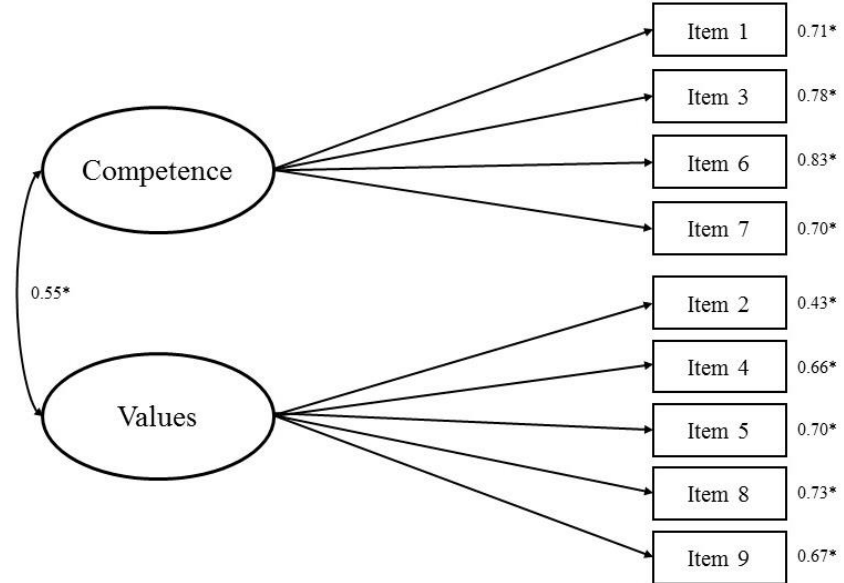
Figure 2. Confirmatory factor analysis results showing standardized estimates with errors for the Korean version of Health Care System Distrust Scale based on the modified two-factor model proposed by Yang et al. [10]. * p < 0.001.